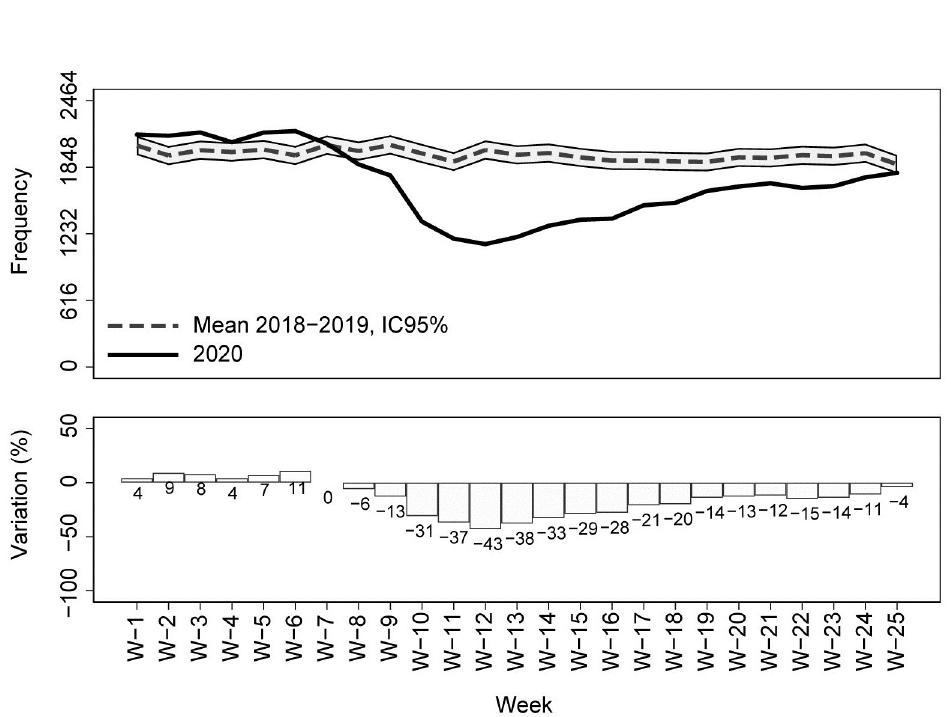
Fig 4. Hospitalizations from the emergency department in Tuscany Region by week (year 2020 vs 2018–19); percentage changes and 95% CIs.